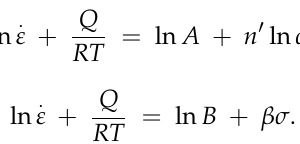
. ε and ( b ) β by plotting σ vs. ln